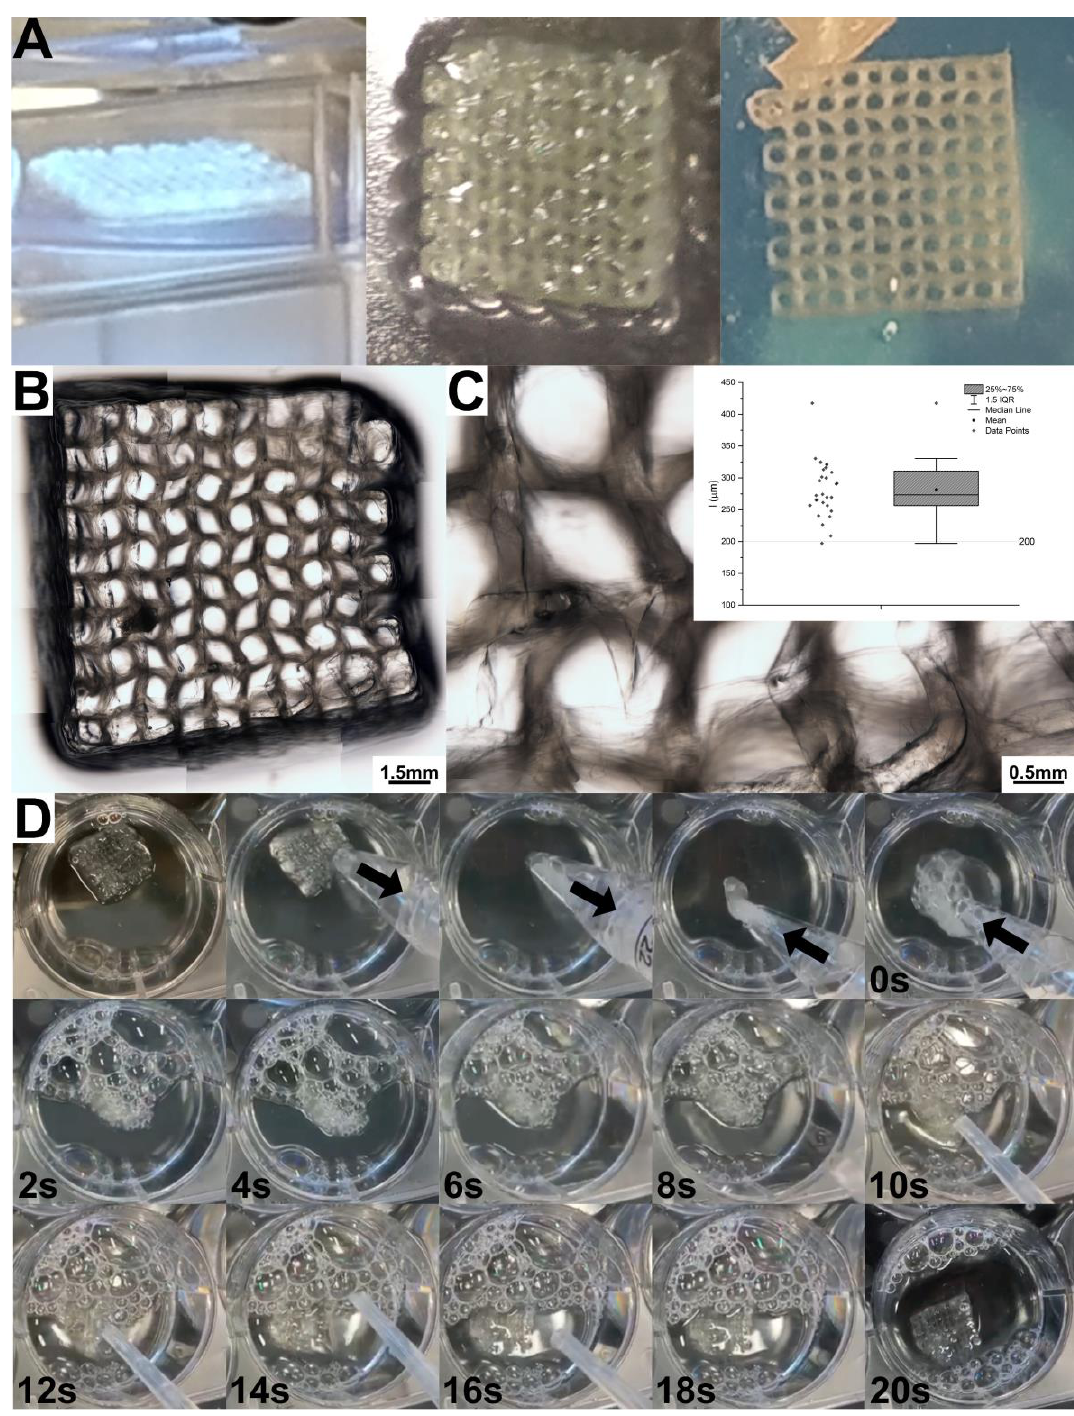
Figure 6. ( A ) Crosslinking of the 3D extrusion-printed Sil-MA structure by UV-irradiation and obtained structure embedded in poloxamer. ( B ) Brightfield microscopy, composed by several micrographies and ( C ) a singular micrography, wherein the quantification of the filament dimension has been performed. ( D ) Withdrawal, ejection, and shape recovery of a Sil-MA 10-layer